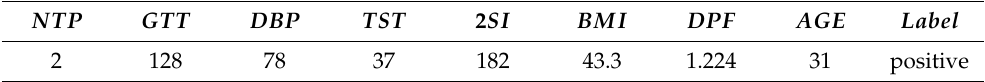
Table 11. Example patient in the positive polygon of Equation